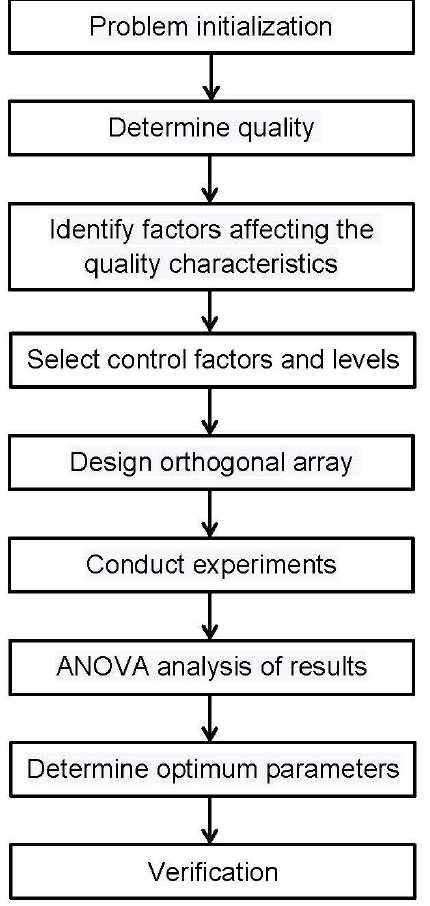
Figure 5. Procedures of the Taguchi method.